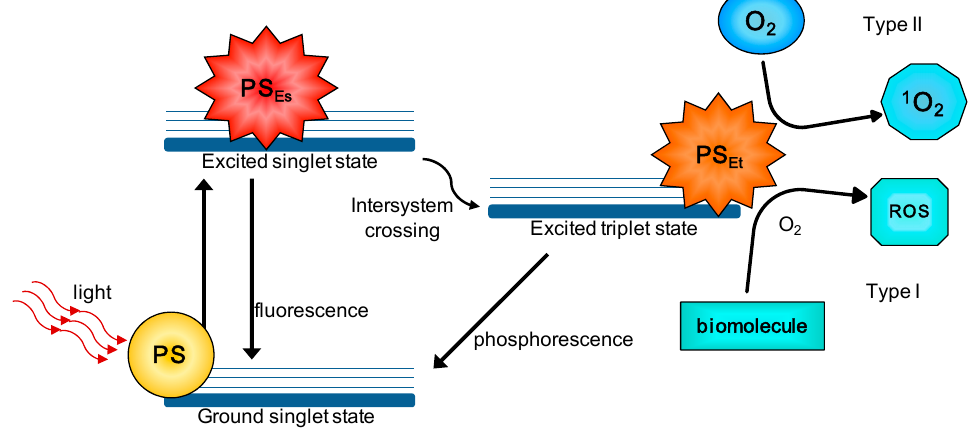
Figure 1. Type I and Type II reactions in PDT (photodynamic therapy). Schematic Jablonski’s diagram showing PDT’s mechanism of action. Following light absorption, the PS reaches an excited singlet state. After an intersystem crossing, the PS, now in a triplet excited state, can react in two ways: react with biomolecules through a hydrogen atom (electron) transfer to form radicals, which react with molecular oxygen to generate ROS (type I reaction); or, the PS in its triplet state can react directly with oxygen through energy transfer, generating singlet oxygen (Type II reaction). PS: photosensitizer; PS Es :